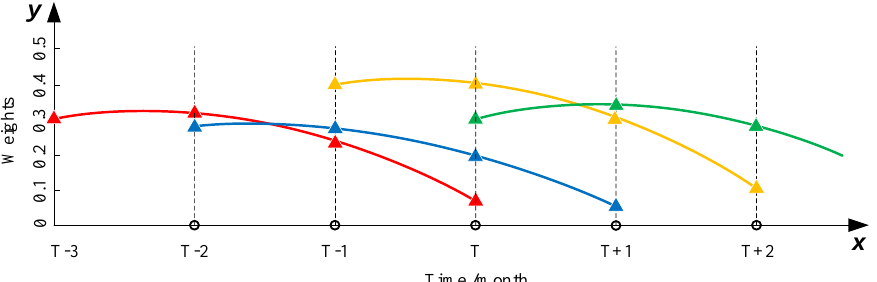
Figure 3. Consecutive impacts of climate factors on vegetation in different months. Note: The curves of red, blue, yellow, and green represent the influence of climate factors from (T − 3), (T − 2), (T − 1), and T months to vegetation growth in the following months, respectively. The triangle represents the intersection of the curve and the dashed line. The y -value at the intersection represents the influence weights of the climate factors on vegetation in the corresponding month.